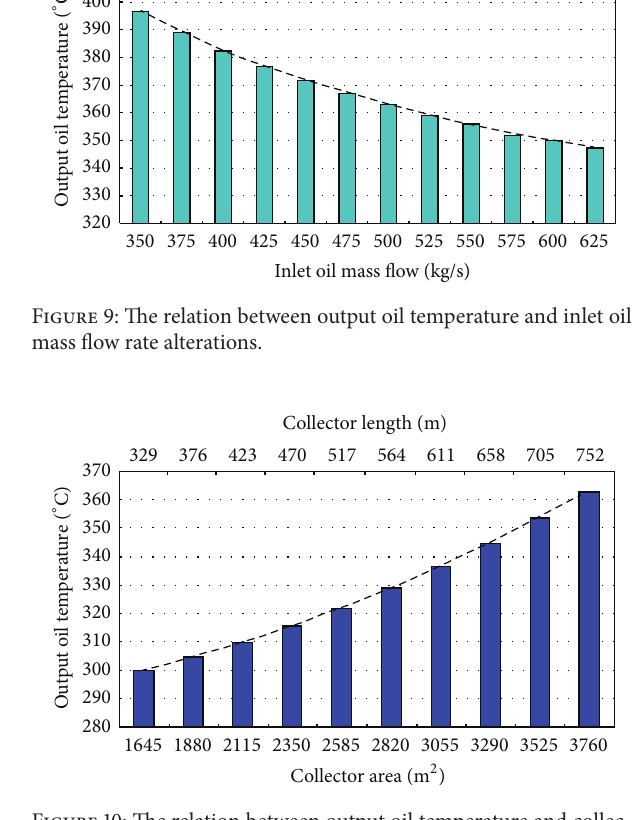
Figure 10: The relation between output oil temperature and collec- tor area (length)